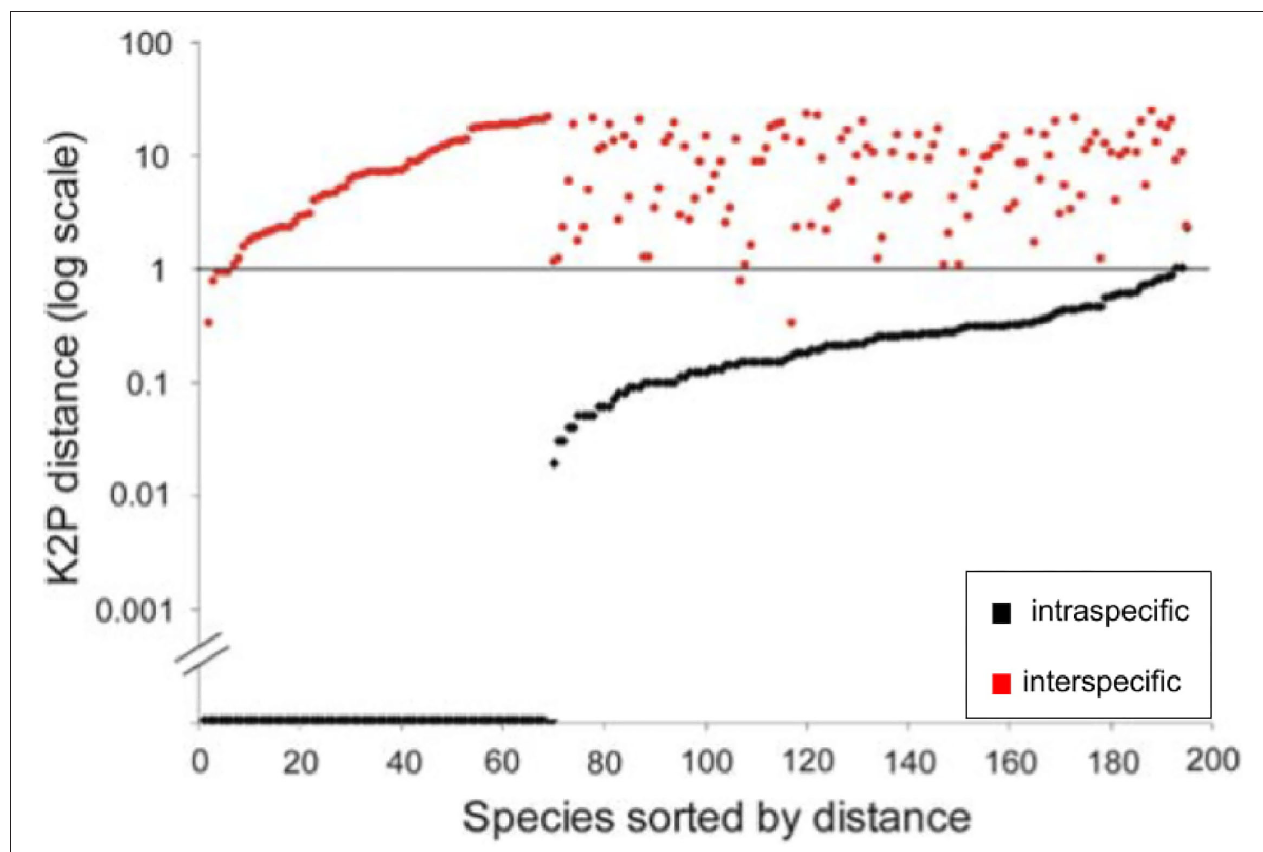
FIGURE 2 | Half logarithm dotplot for the display of species’ genetic distances modified from Steinke et al. (2009a) for fishes from Pacific Canada. Plotted data comprise those specimens originally analyzed by Steinke et al. (2009a) ( i.e. , 1225 specimens from 201 species). Most sampled species are resolved at the 1% log level of genetic